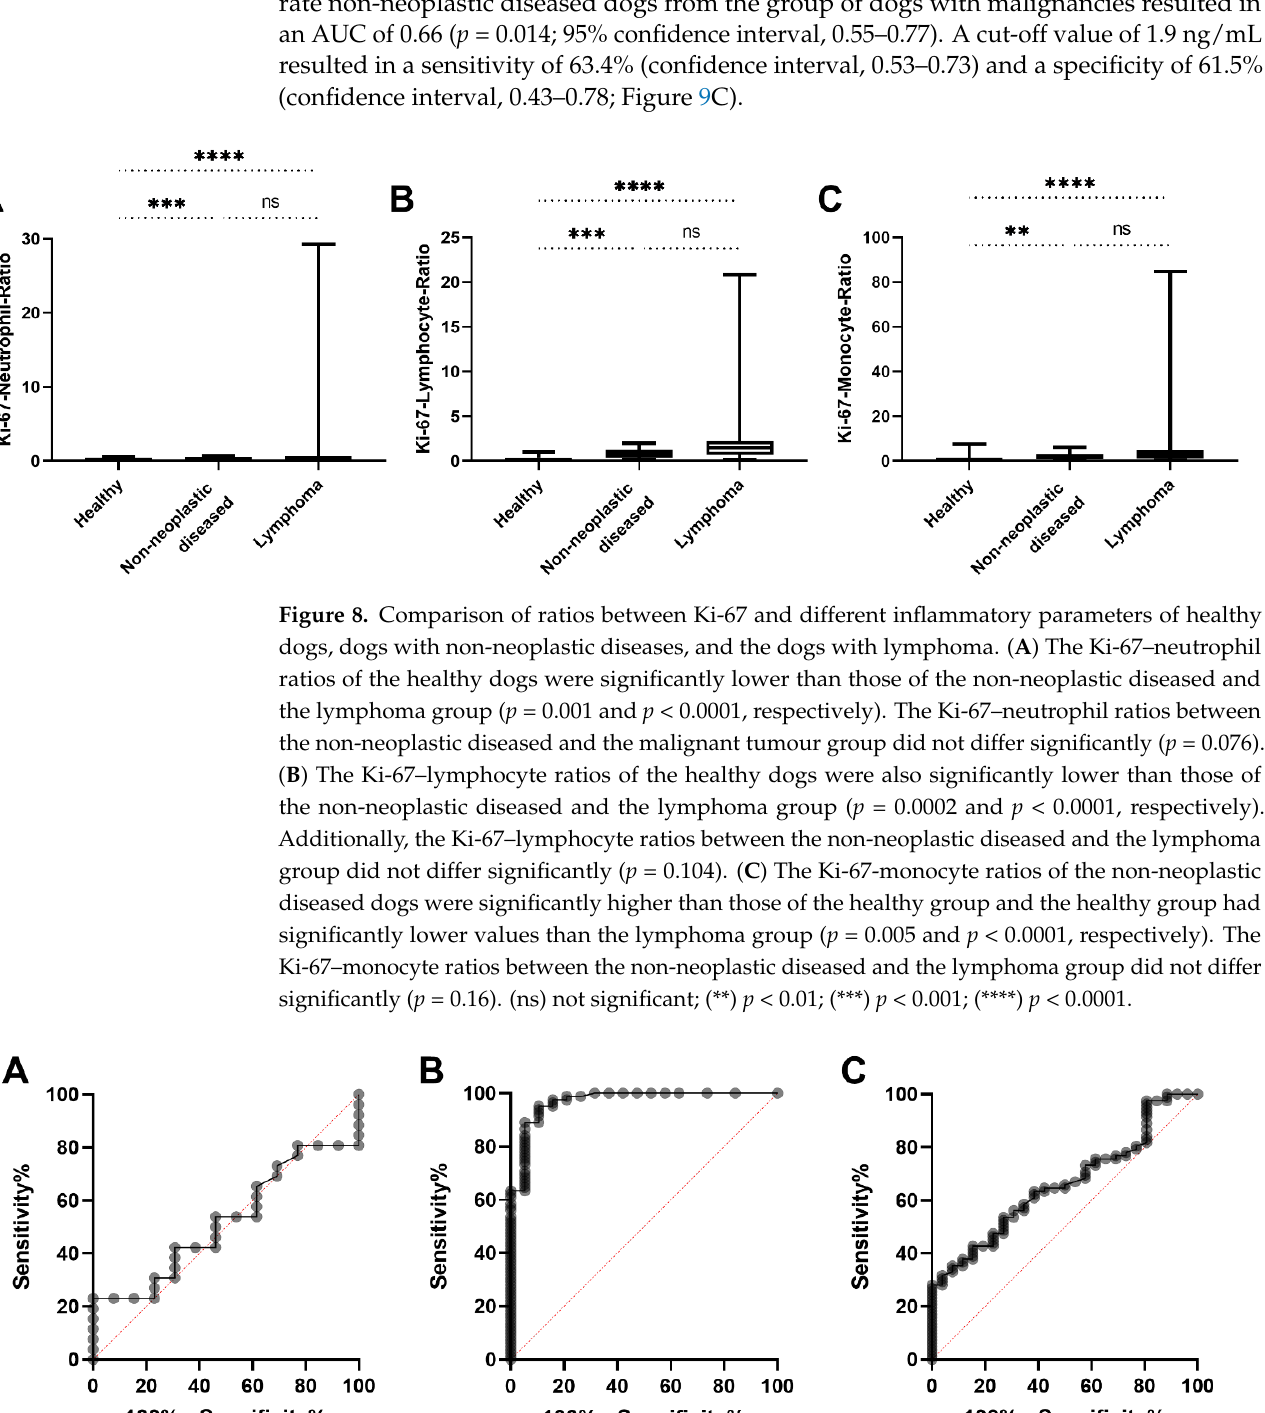
14 of 21 Figure 7. Comparison of ratios between Ki-67 and different inflammatory parameters of healthy